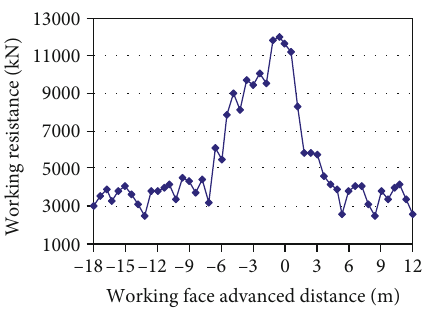
Figure 8: Support working resistance curve of the working face through the abandoned roadway.